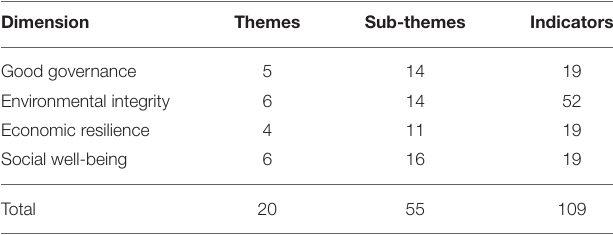
TABLE 2 | Structure of the Sustainability Assessment of Food and Agriculture (SAFA).